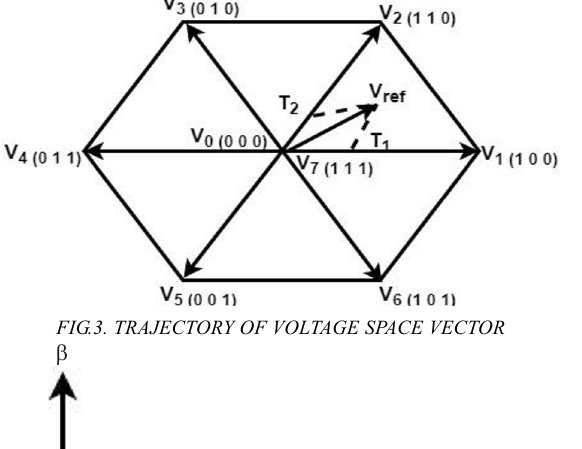
FIG.3. TRAJECTORY OF VOLTAGE SPACE VECTOR